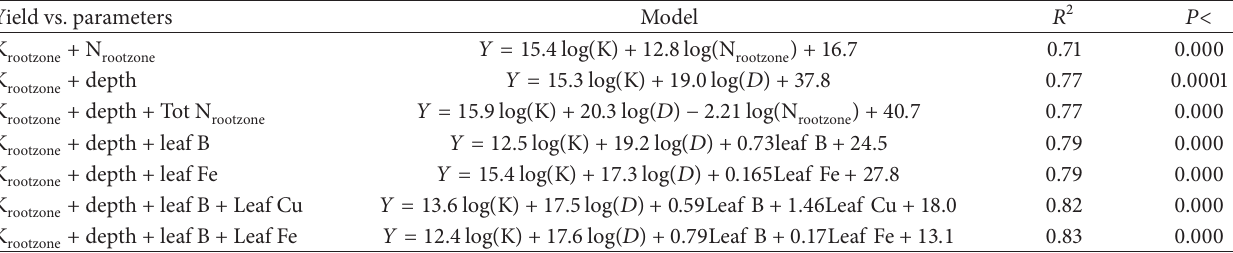
Table 6: Multiple regressions between olive fruit yield (𝑌) and soil/land factors (𝑥) . Coefficients of determination (𝑅 2 ) and statistical significance (𝑃) are also presented.